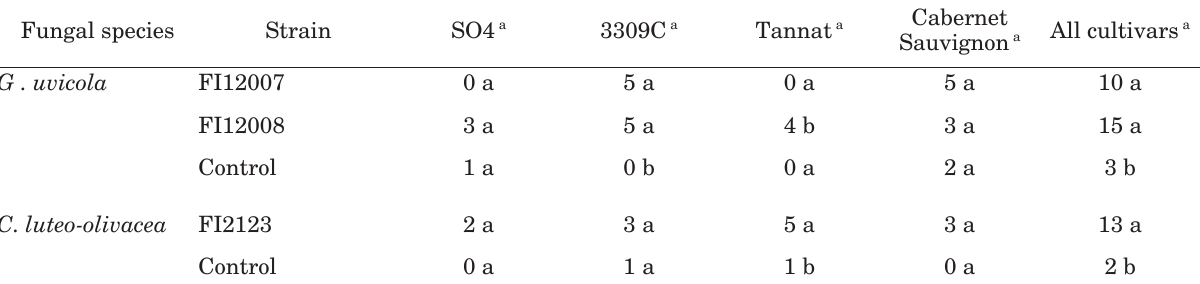
Table 4. Direct amplification from plant material inoculated with Greeneria uvicola and Cadophora luteo-olivacea . Fungal